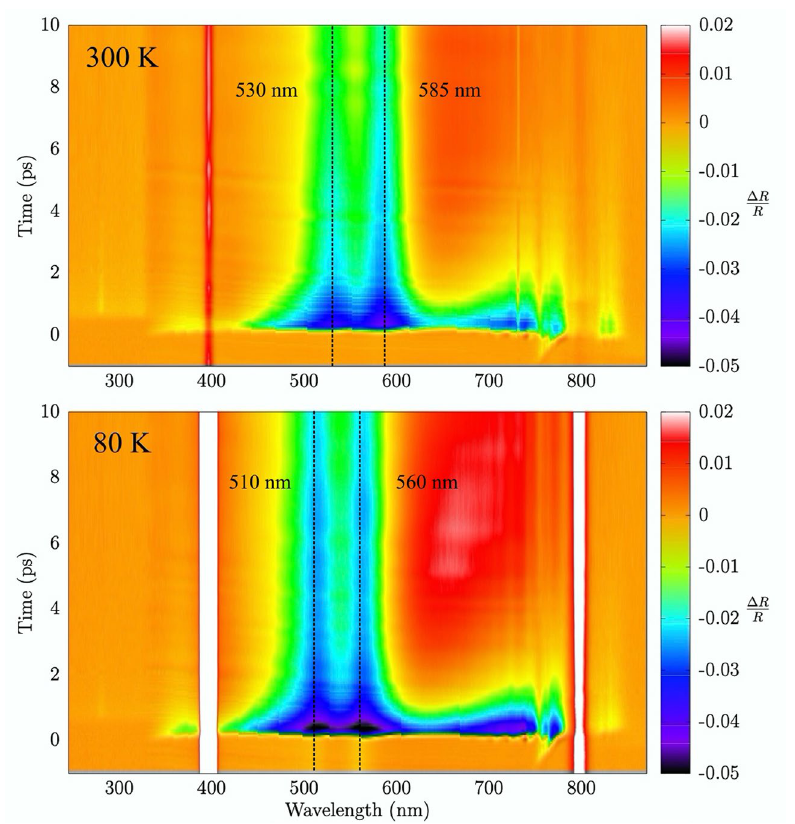
Figure 5. Transient reflectivity spectra of germanium measured at fluence of 16 mJ/ cm 2 and at different initial temperatures of the